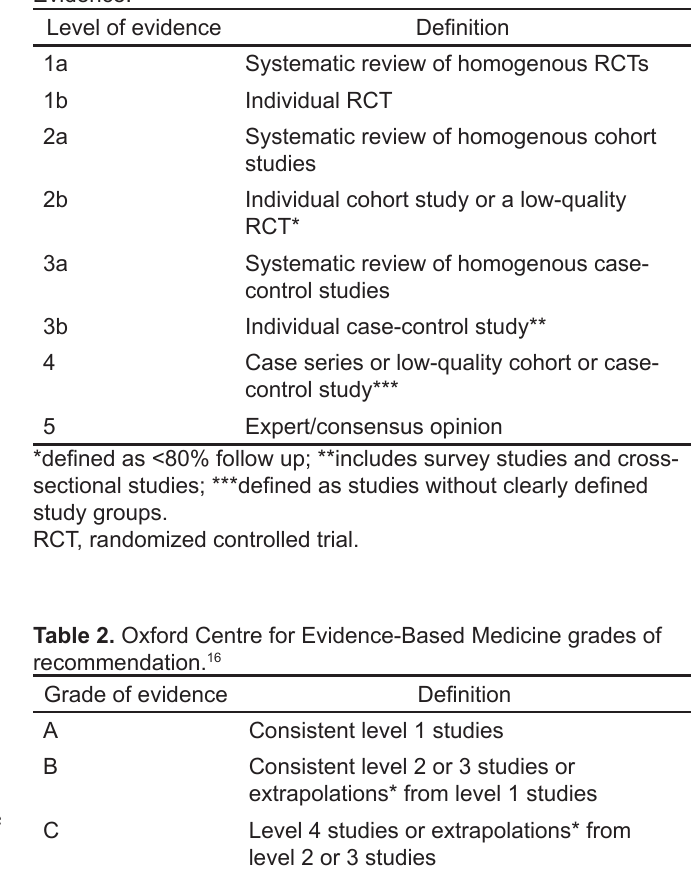
Table 1. Oxford Centre for Evidence-Based Medicine Levels of Evidence. 16